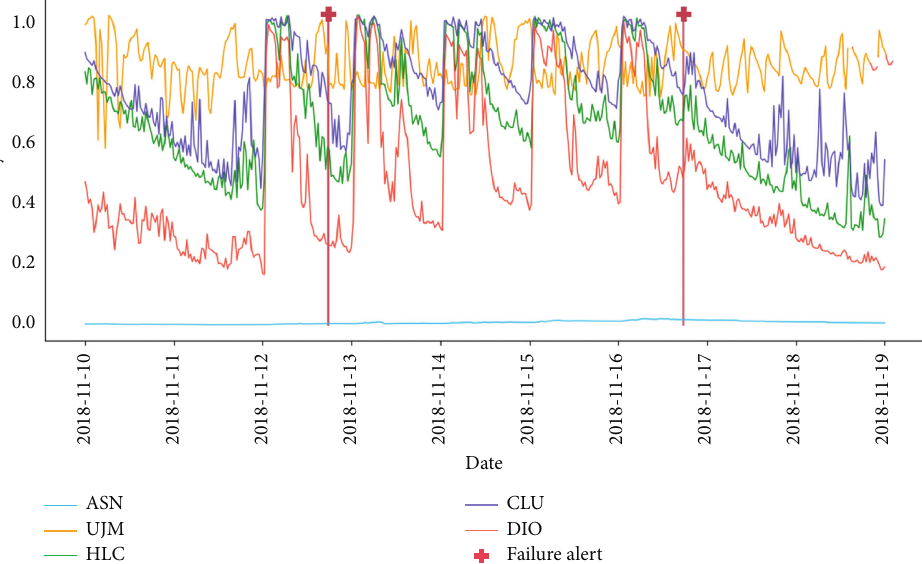
Figure 2: Results from EXPoSE and alerts of one node.